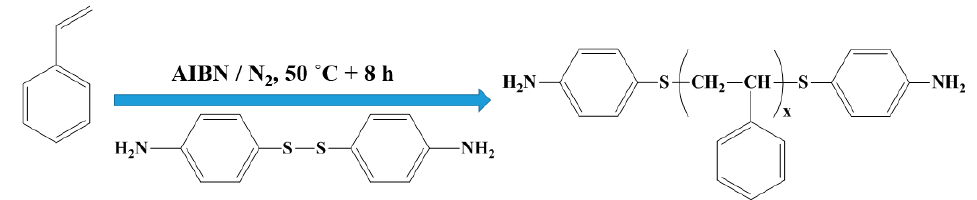
Scheme 1. Preparation of amino endcapped PS.